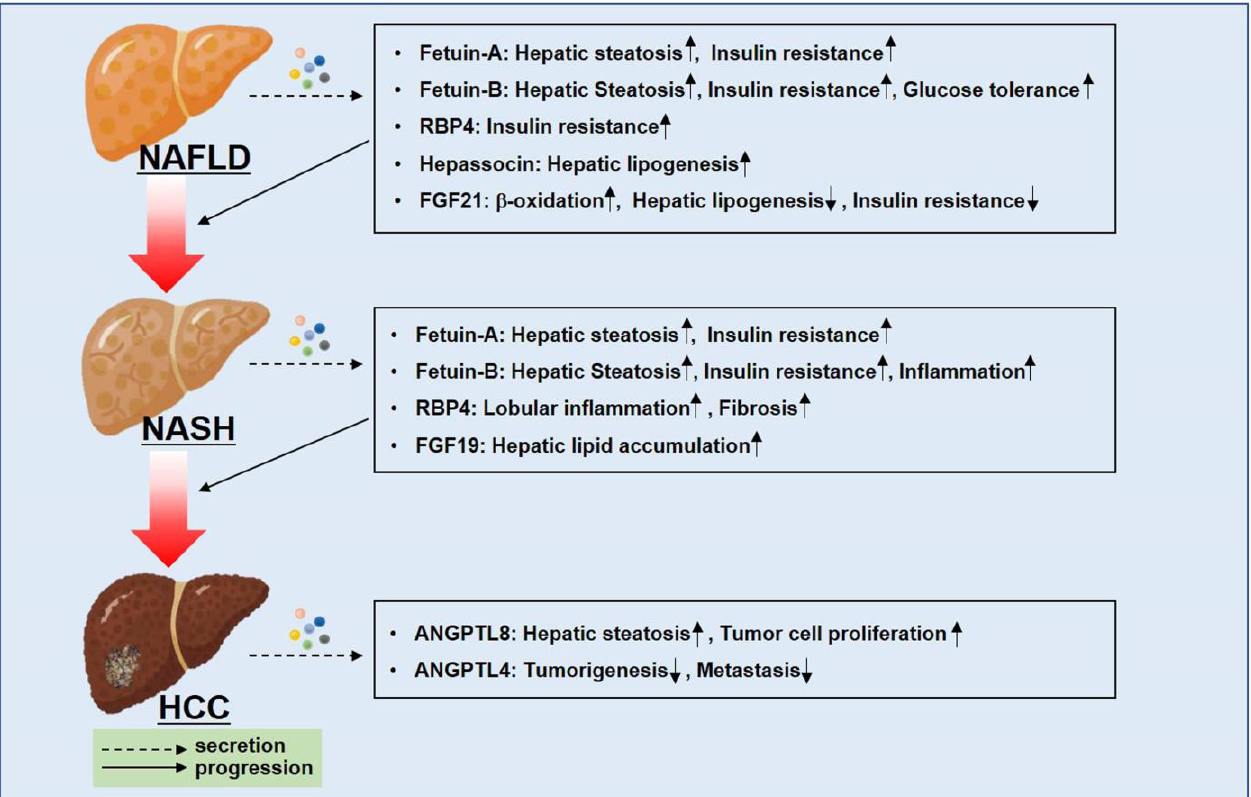
Figure 6. Hepatokines that are secreted from the liver are closely associated with the progression from NAFLD to NASH to HCC. Hepatokines including Fetuin-A, Fetuin-B, RBP4, and FGF19 play an important role in NAFLD and NASH. They are associated with hepatic lipid accumulation, insulin resistance, and inflammatory signaling pathways. Additionally, ANGPTL4 and 8 tend to function in opposite ways in HCC tumorigenesis.